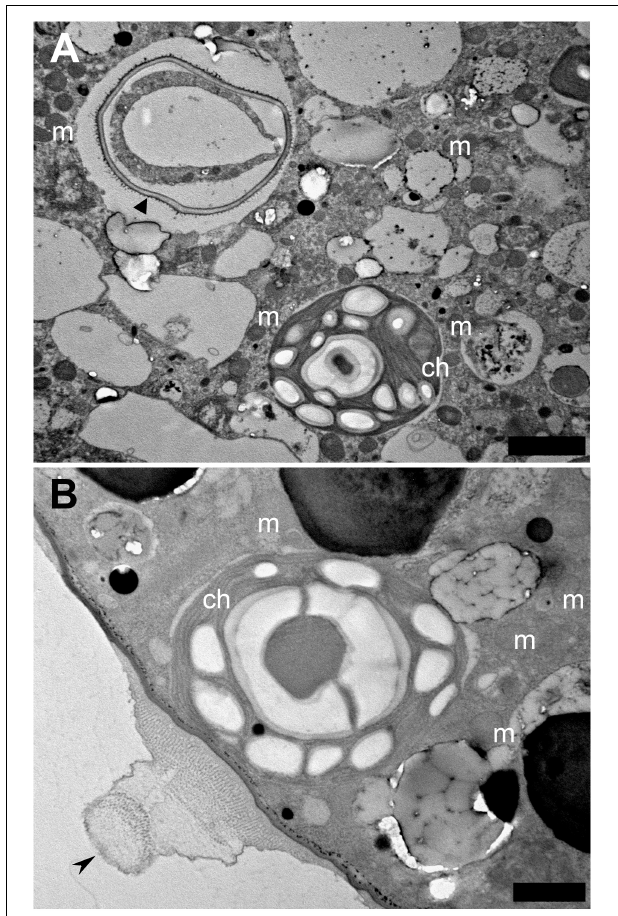
FIGURE 3 | Transmission electron micrographs of captured Chlorella chloroplast. (A) Captured Chlorella chloroplast (ch) that is shedding its cell wall (arrowhead), is within the foraminiferal vacuole. Mitochondria (m) are visible. Scale bar = 2 µ m. (B) Sometimes captured Chlorella chloroplasts are found localized at the foraminiferal cell periphery, just beneath the pore plug (arrowhead). Scale bar = 1 µ